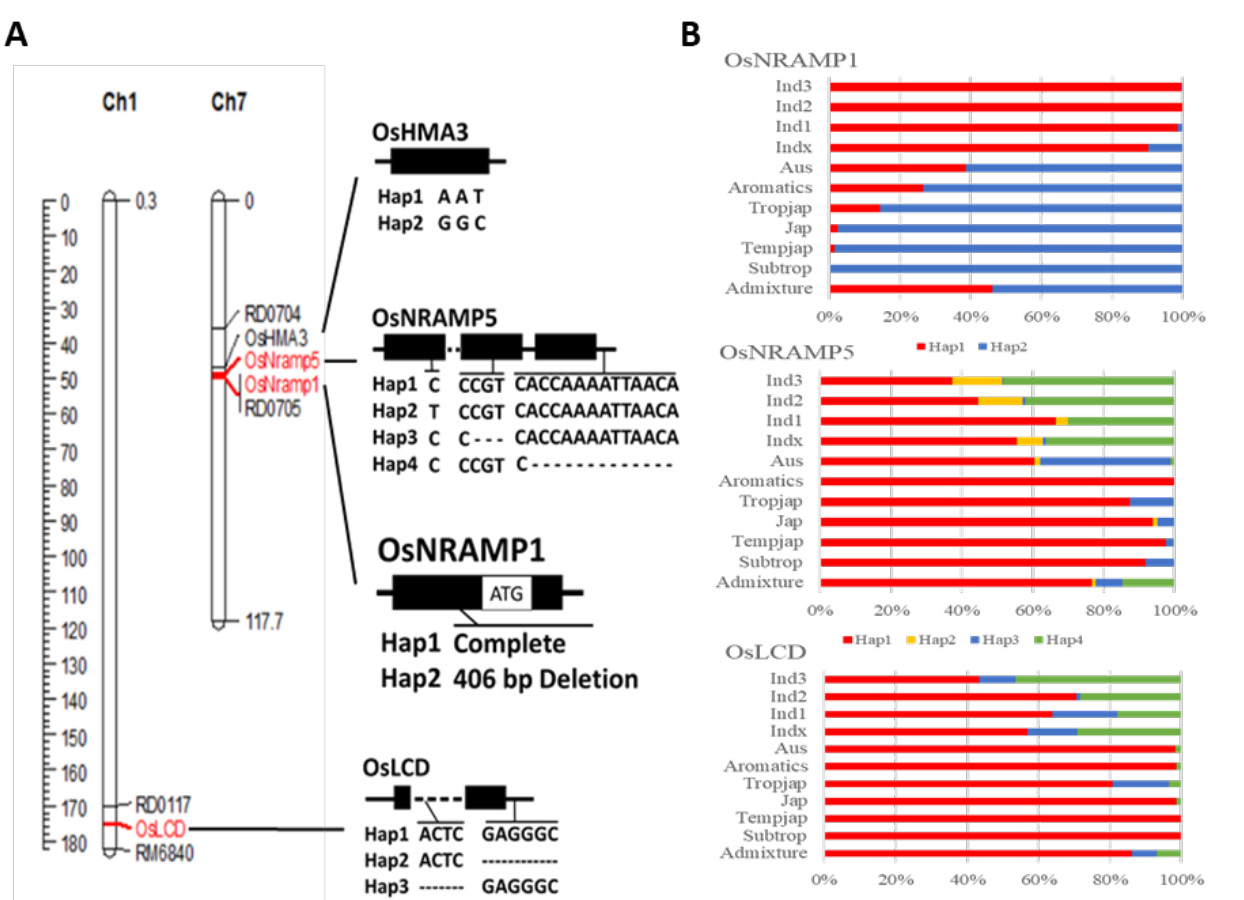
Figure 1. The haplotypes of OsHMA3 , OsNRAMP1 , OsNRAMP5 , and OsLCD ( A ) and their distribu- tions among 3K-RGP accessions ( B ). Subpopulation designation is based on Alexandrov et al. (2015) [33]. Ind1, ind2 and ind3 are three groups of indica rice, indx corresponds to other indica varieties, temp is temperate japonica , trop is tropical japonica , temp/trop and trop/temp are admixed temperate and tropical japonica varieties, japx is other japonica varieties, Aus is aus , inax is admixed aus and indica , Aromatics is aromatic and admixture is all other unassigned varieties.